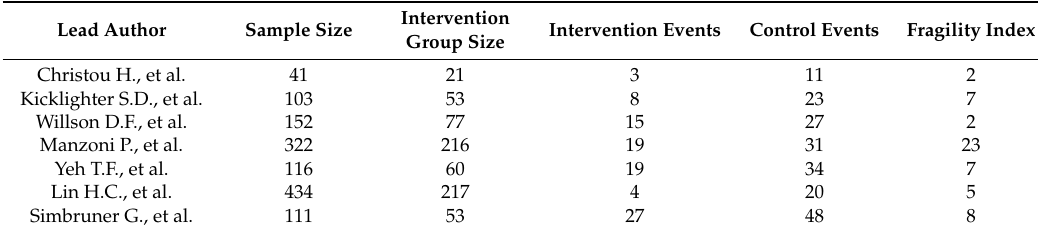
Table 1. Summary of included RCTs and extracted data